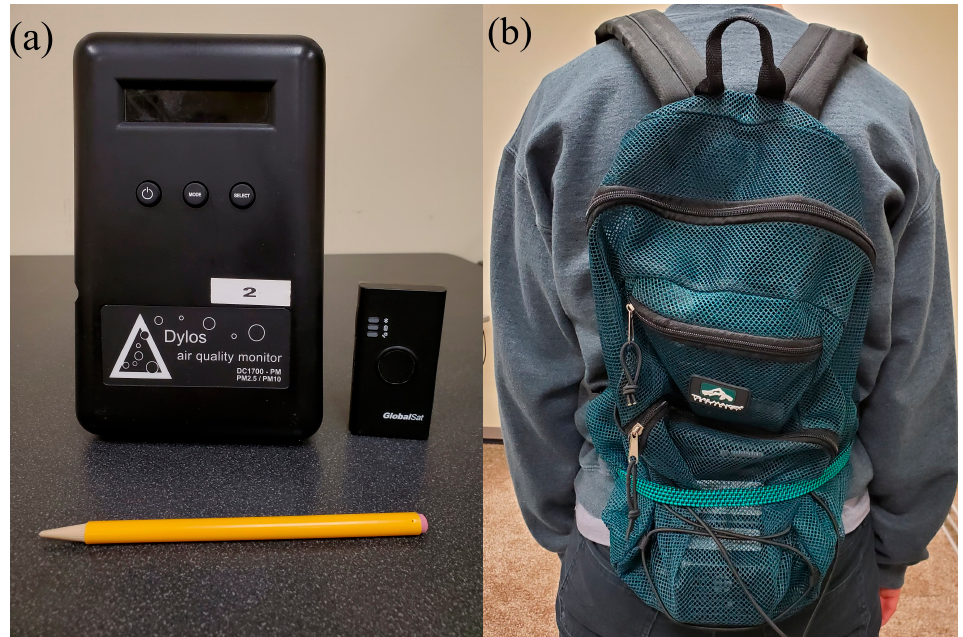
Figure 2. ( a ) The Dylos sensor and GPS units used to measure outdoor fine particulate matter with an aerodynamic diameter of less than 2.5 µm (PM 2.5 ) concentration and record travel trajectory, respectively, with a pencil for size reference; ( b ) the outfit of the two devices in a meshed backpack.